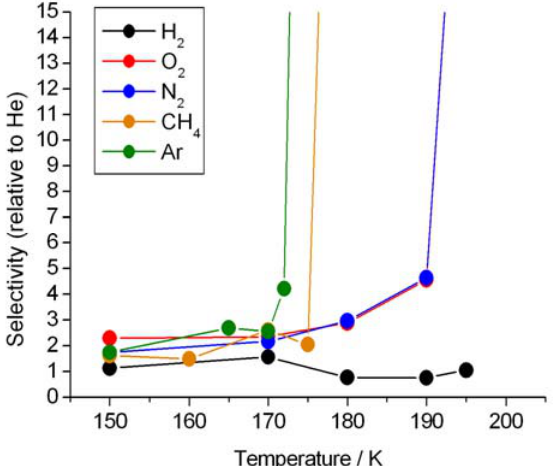
selectivity of argon, methane, nitrogen, oxygen and hydrogen, relative Figure 4. Ice I h to